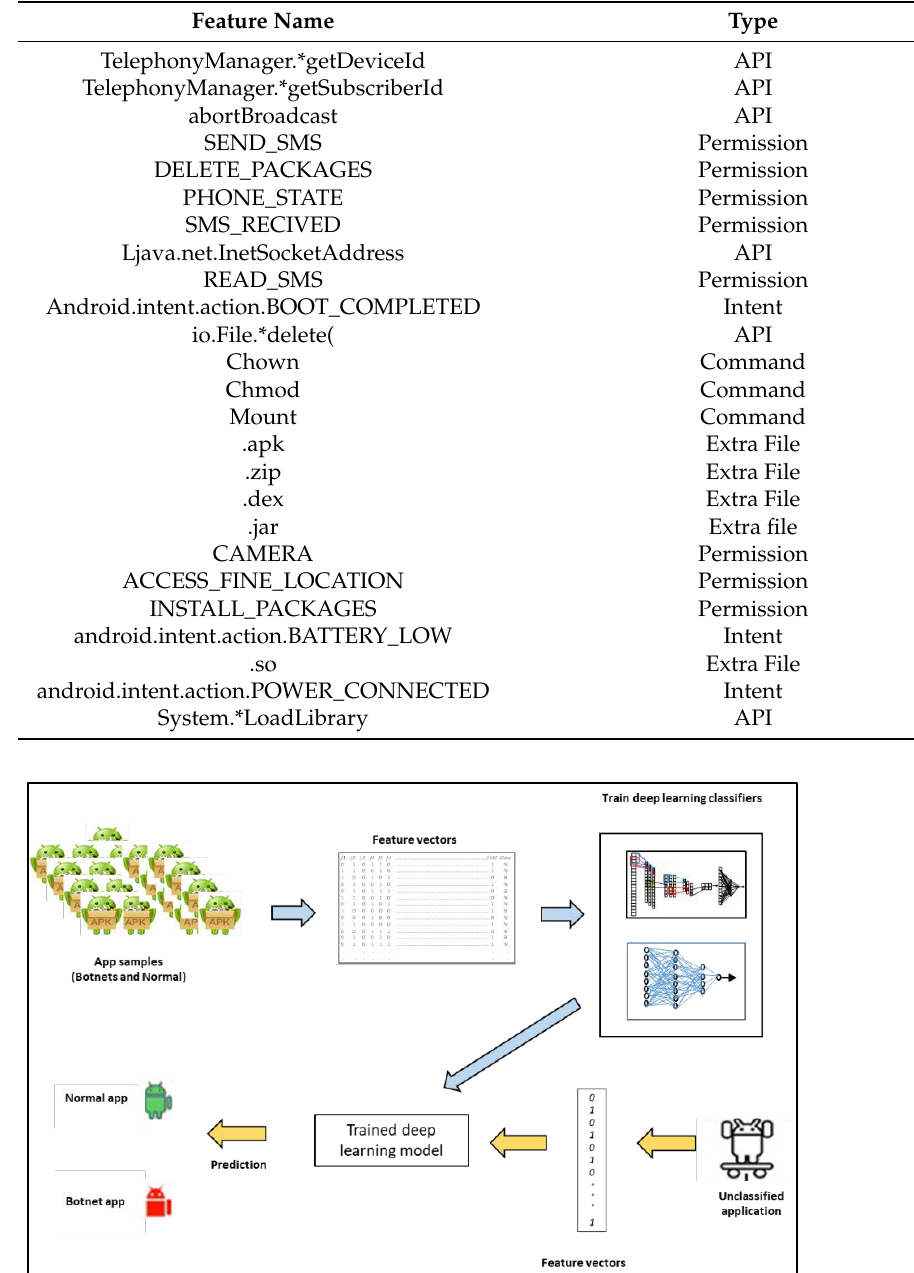
Table 2. Examples of features extracted for the deep learning models.